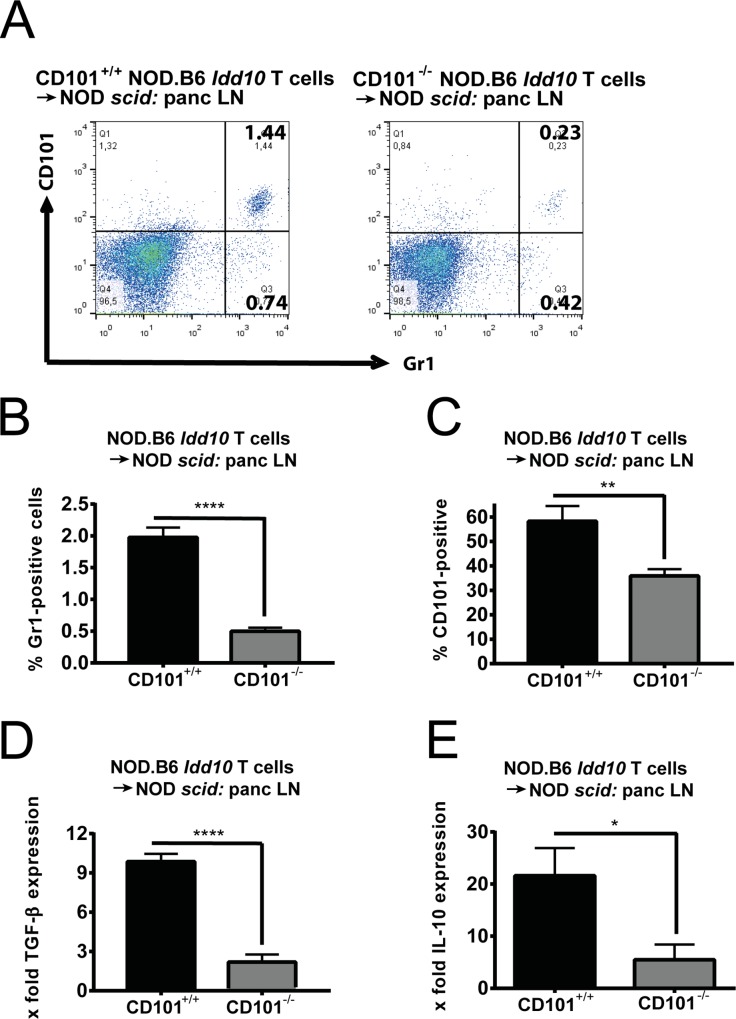
Protection from T1D is associated with an accumulation of CD101-expressing myeloid cells.Gr1-positive cells have reduced accumulation and CD101 expression (A-C) in the pancreatic lymph nodes of NOD scid recipients of CD101−/− as compared to CD101+/+ NOD.B6 Idd10 T cells. Representative FACS dot plots of Gr1-expressing myeloid cells in the pancreatic lymph nodes are displayed (A) as well as the percentages of Gr1-expressing cells (B) and the distribution of CD101 expression on them (C) compiled from 5 recipients in each cohort. Gr1-expressing myeloid cells from recipients of CD101−/− donor cells express significantly less TGF-β (D) and IL-10 (E) (N = 4 in each cohort for D and E). TGF-β and IL-10 mRNA copies were determined by RT-qPCR in purified Gr1-expressing cells. The ratios of the TGF-β and IL-10 mRNA copies relative to the HPRT copies were calculated. Statistically significant differences were determined using Student´s t-tests (*, p<0.05; **, p<0.01; ***, p<0.001; ****, p<0.0001). Error bars indicate the SD of the mean.